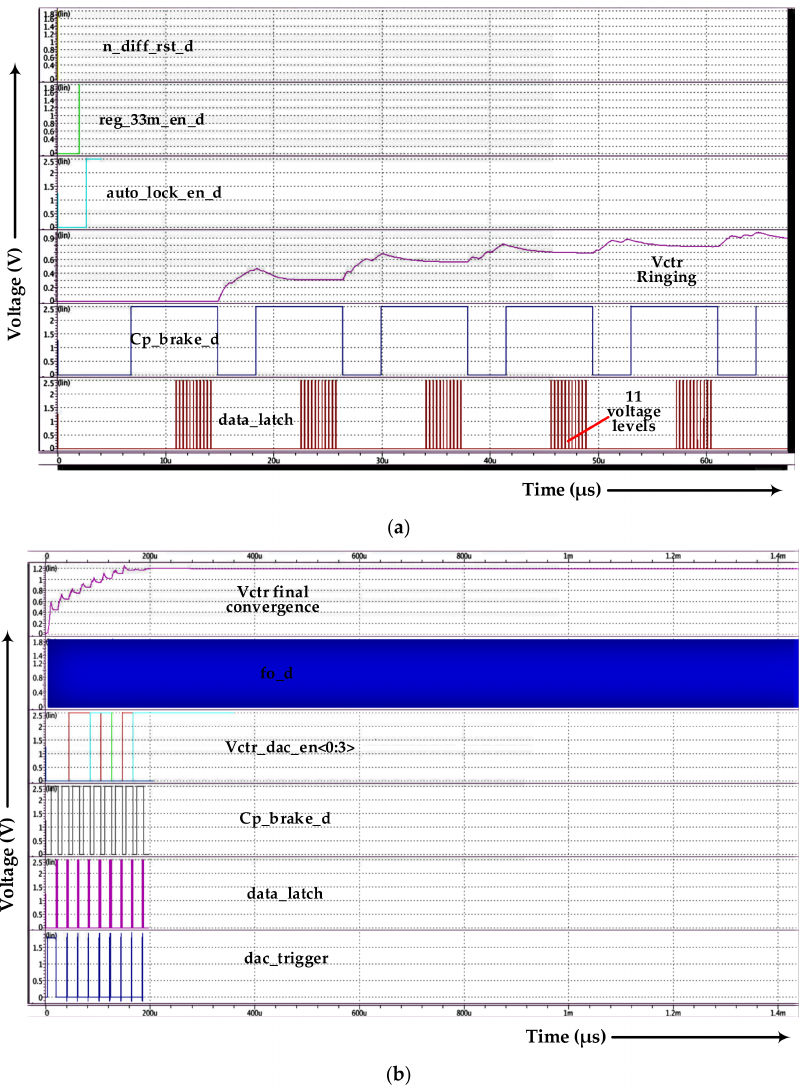
Figure 5. Simulation results of ( a ) automatic band selection circuits (ringing) and ( b ) automatic band selection circuits (final convergence).